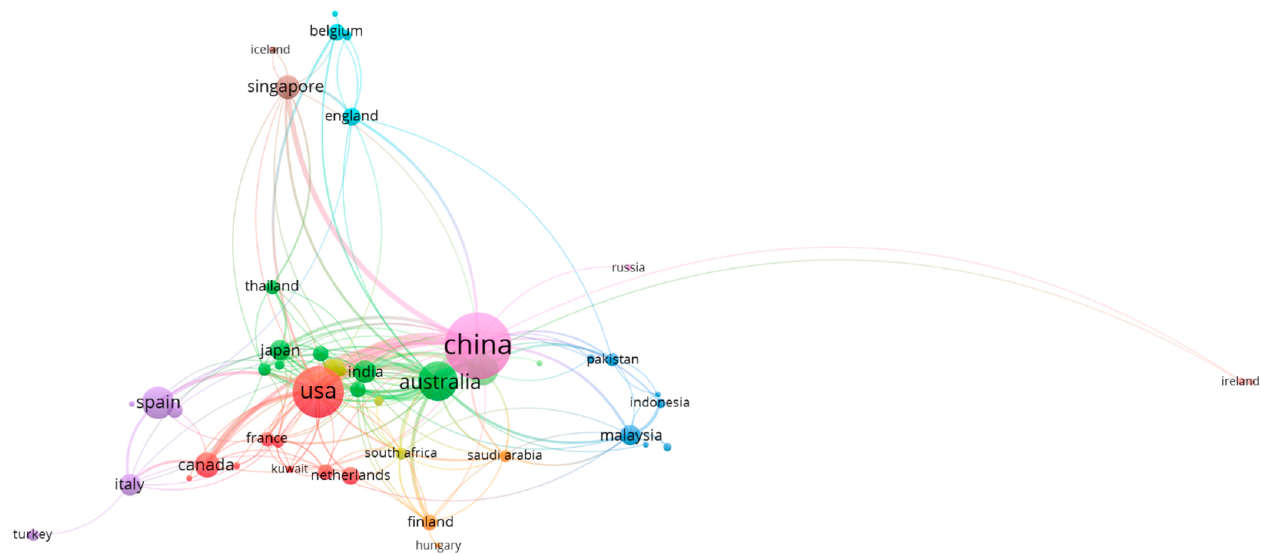
Figure 5. A map of the most cited countries based on the number of documents.